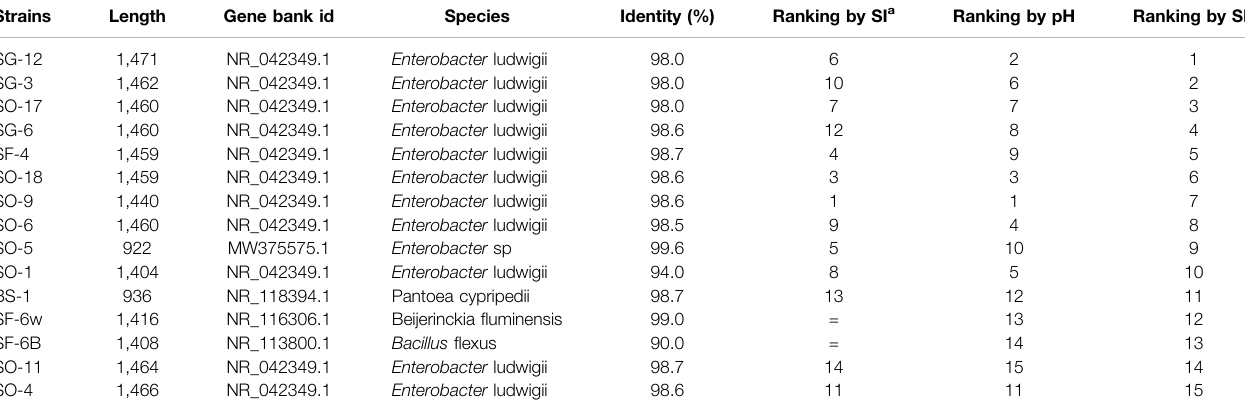
TABLE3| Identi fi cationandrankingsofselectedPSBstrainsisolatedfromrhizospheresofnativeplantsincludingbluestem(BS),sawgrass(SG),swordfern(SF),andseaox- eye daisy (SO) in Miami-Dade County, Florida based on 16S rRNA gene sequence and GenBank with BLAST.